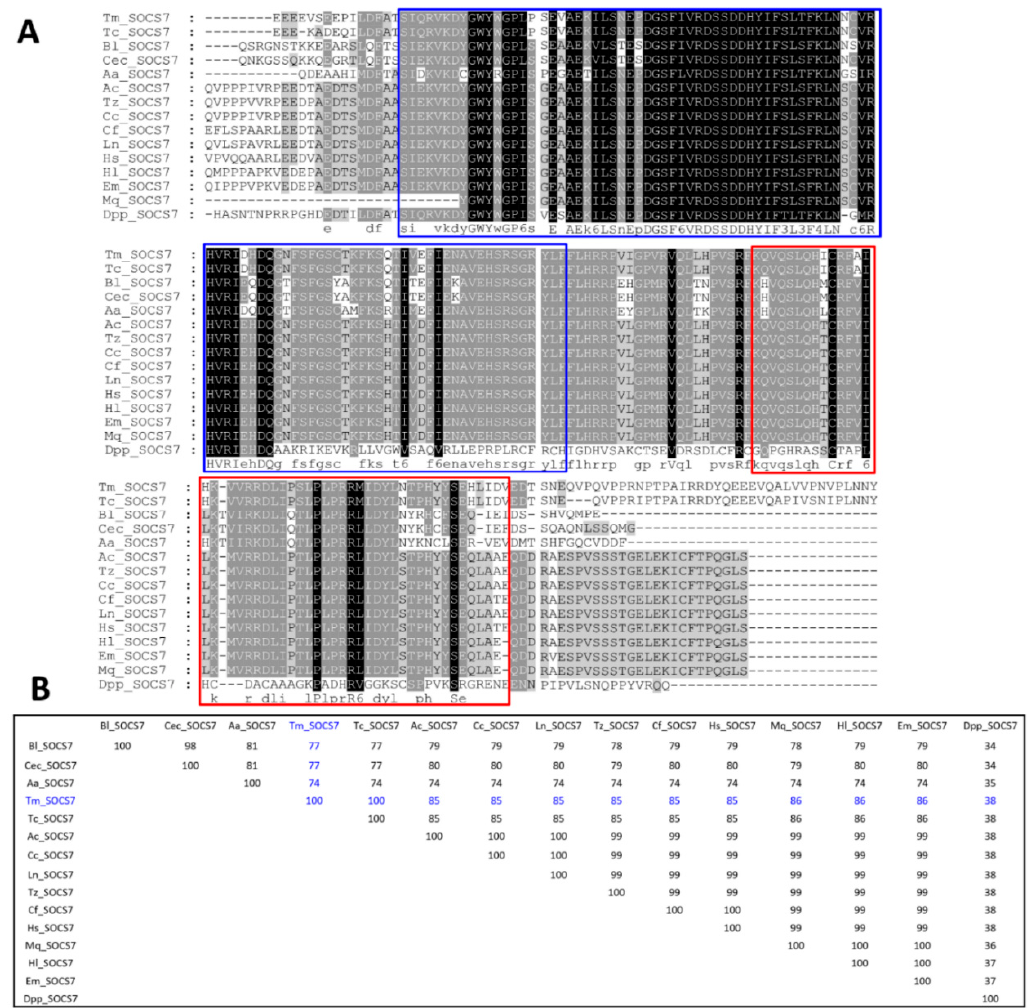
Figure 6. Alignment and identity of TmSOCS7 to other SOCS7 proteins: ( A ) Multiple alignment of the SOCS7 C-terminal sequences of insect orthologs. The SH2 and SOCS box domains are shown in blue and red boxes, respectively. Identical residues in all sequences are shaded black, and similar sequences are shaded grey. Deletions are indicated by dashes; ( B ) Percent identity matrix of SOCS7 proteins using the amino acid sequences from representative insect species. ClustalX2 was used to generate the identity matrix. The sequences used in the analysis were from Tribolium castaneum (XP_008190646.1), Bactrocera latifrons (JAI49983.1), Ceratitis capitata (JAC02138.1), Aedes aegypti (XP_021707758.1), Acromyrmex echinatior (EGI60822.1), Trachymyrmex zeteki (KYQ56054.1), Cyphomyrmex costatus (KYM98051.1), Camponotus floridanus (EFN69786.1), Lasius niger KMQ86622),